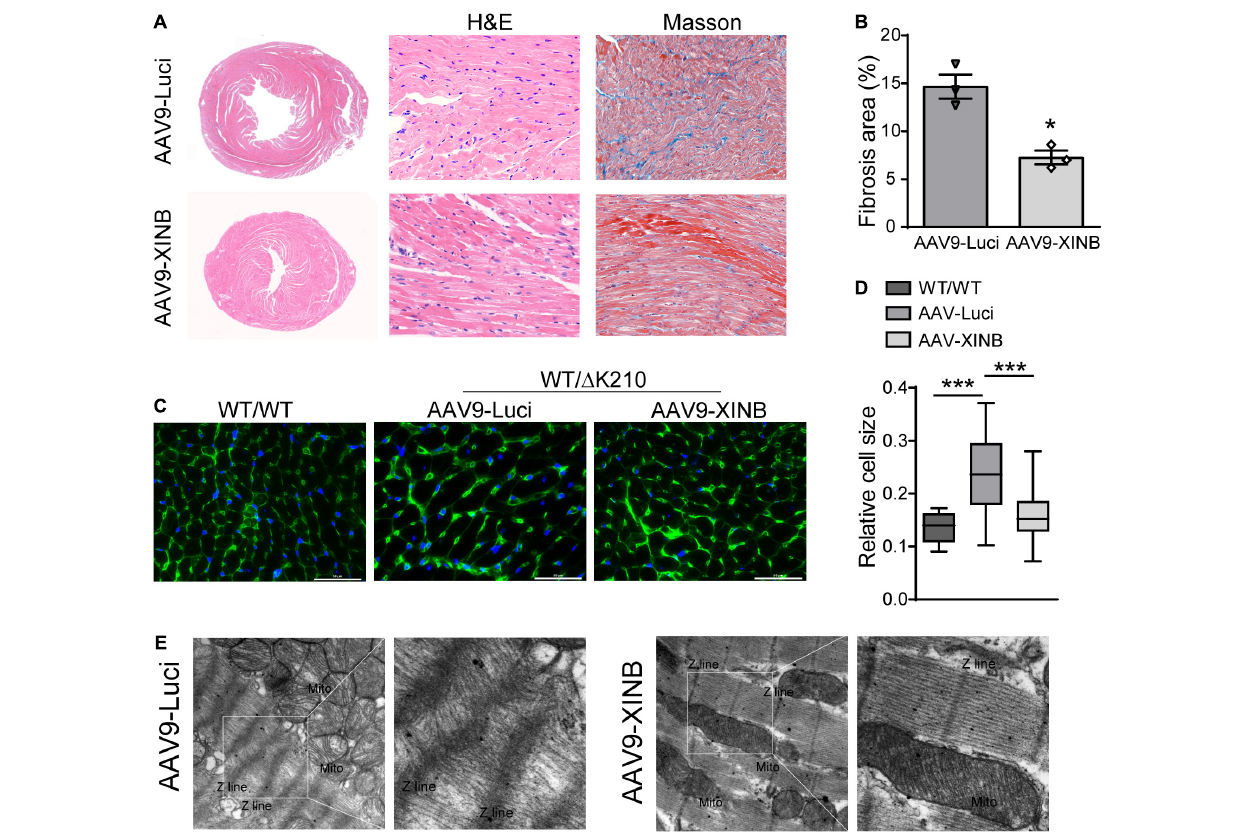
FIGURE 6 | Morphological studies showed cardiac-specific expression of XINB in TNNT2 - (cid:49) K210 mice rescued DCM phenotypes. (A) , Representative H&E staining of the hearts from 3-months old control and AAV9-XINB injected TNNT2 - (cid:49) K210 mice. Masson’s trichrome staining showed less fibrosis in the mutant LV tissue when compared to control. (B) Quantification of interstitial fibrosis area in each group. (C,D) Wheat germ agglutinin (WGA; as an indicator of cardiomyocyte size) staining of left ventricle sections and quantification of myocyte sizes. Scale bars, 50 mm. (E) Ultrastructure of the left ventricular tissue sections from 3-months old mice revealed by transmission electron microscopy at × 6,000 magnification. AAV9-XINB treatment significantly improved the sarcomeric structure of TNNT2 - (cid:49) K210 mice. Data are represented as mean ± SEM. *P < 0.05, ***P <